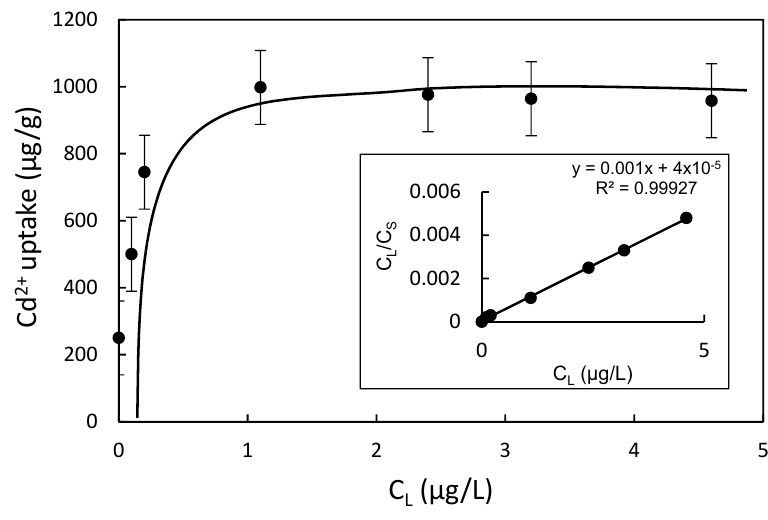
Figure 10. Uptake of Cd 2+ on CMS. The inset is the linear Langmuir fit to the observed data. Table 1. Langmuir and Freundlich parameters for Cd 2+ uptake on CMS. Langmuir Constant